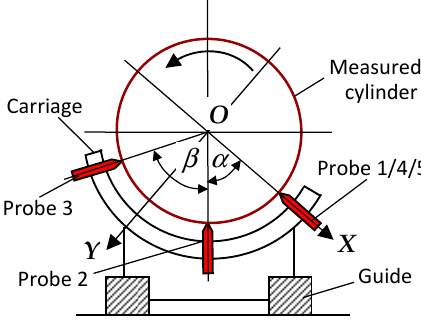
Figure 7. Angular positions of Probes 1–5.